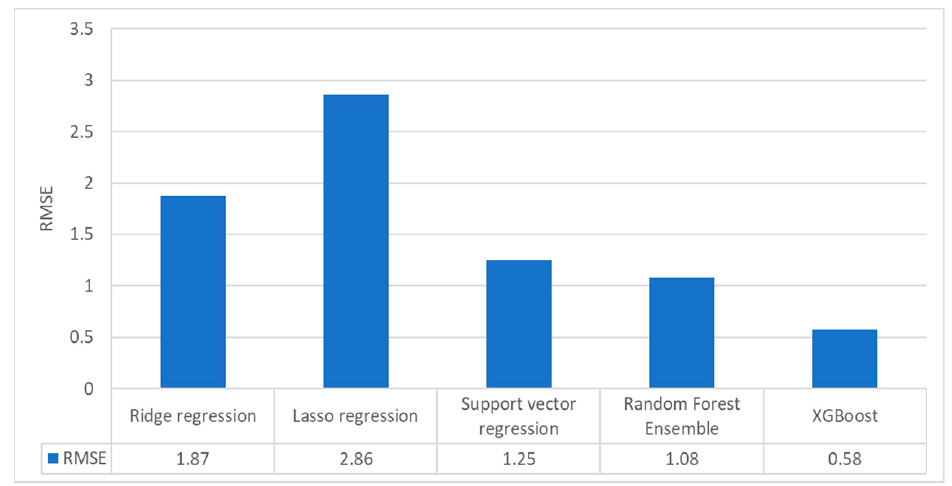
Figure 11. Bar graphs representing the TiO 2 estimation performance of the five machine learning algorithms when applied to the training/validation dataset (Dataset I).